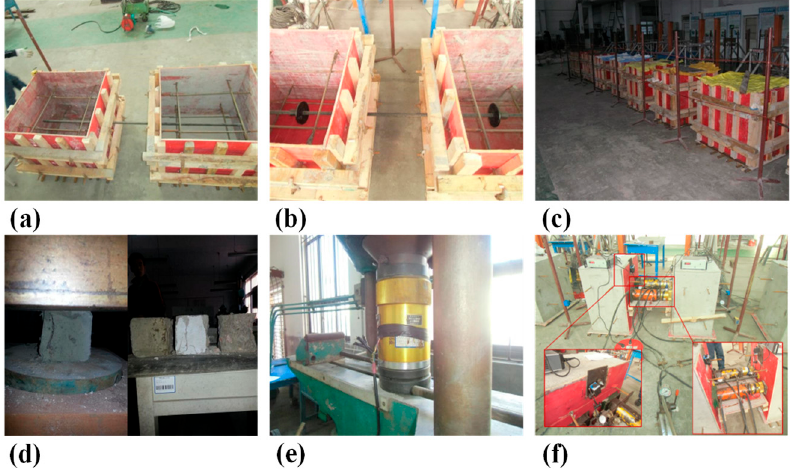
Table 1. Test material parameters.